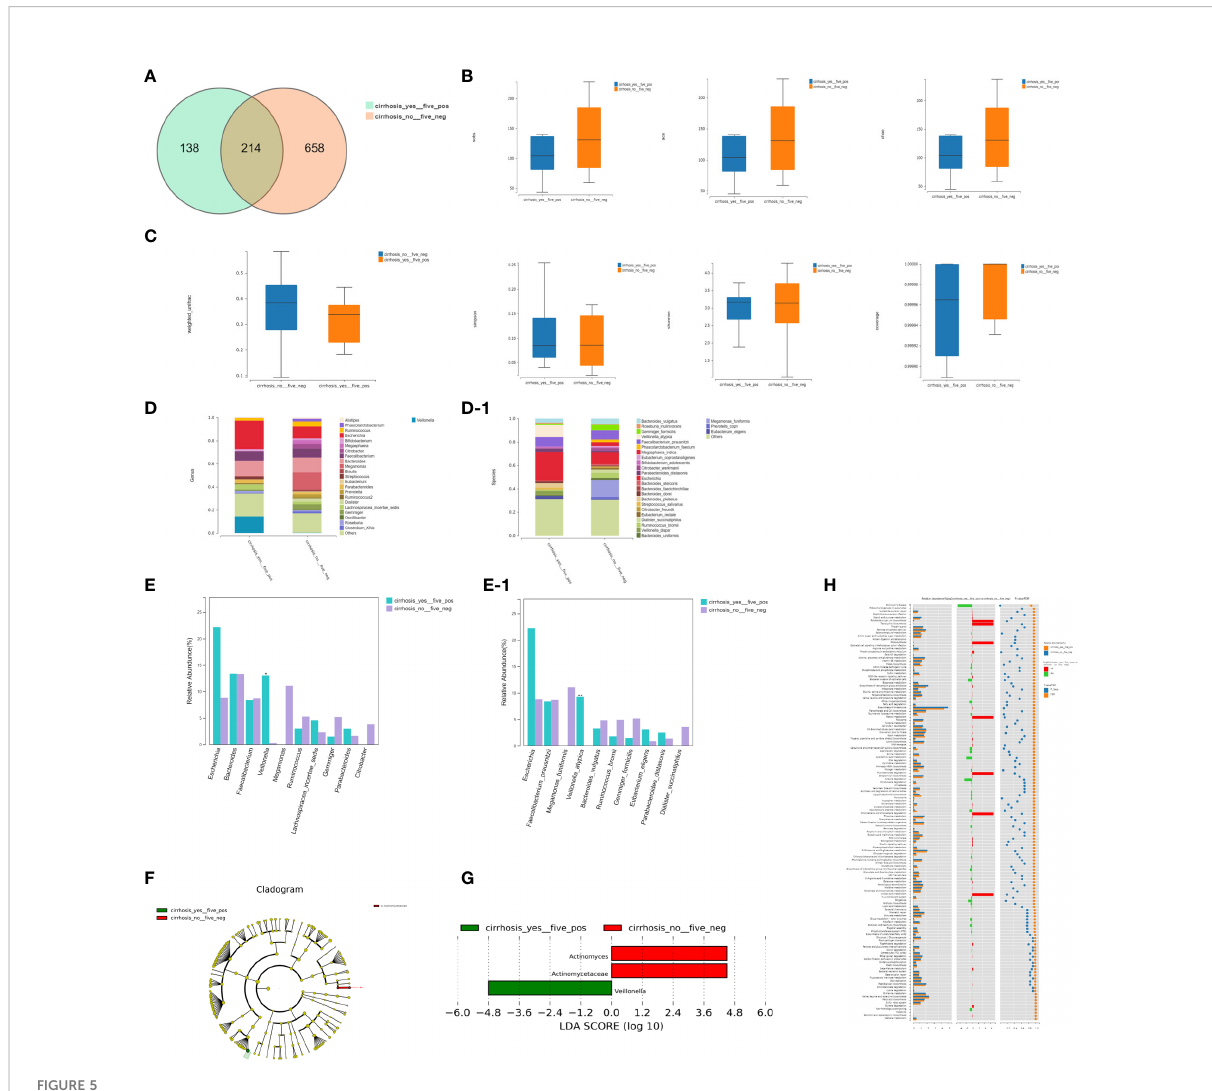
FIGURE 5 Bacterial richness, diversity, and function. (A) We detected 214 shared universal OTUs in FHRAC-positive patients with LC (n=5) and FHRAC- negative patients without LC (n = 13). Samples from FHRAC-positive patients with LC contained fewer unique OTUs than did FHRAC-negative patients without LC (138 vs. 658). (B) a -diversity analysis showed no signi fi cant differences in the Simpson ’ s, Shannon ’ s, Sobs, ACE, Chao, or other coverage indexes between the two groups ( P > 0.05). (C) The microbial communities did not statistically differ between the two groups ( P >0.05). (D, D-1) Twenty-four bacterial genera and 27 bacterial species were detected (E, E-1) . The abundances of Veillonella at the genus level and Veillonella atypica at the species level were greater in the FHRAC-positive patients with LC than in the FHRAC-negative patients without